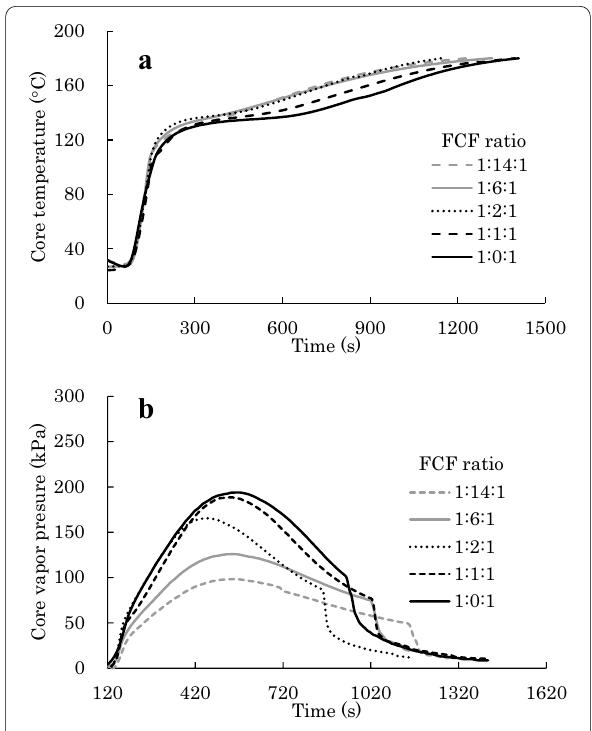
Fig. 3 Typical core a temperature–time and b vapor pressure–time curves in the FCF ratio mat series